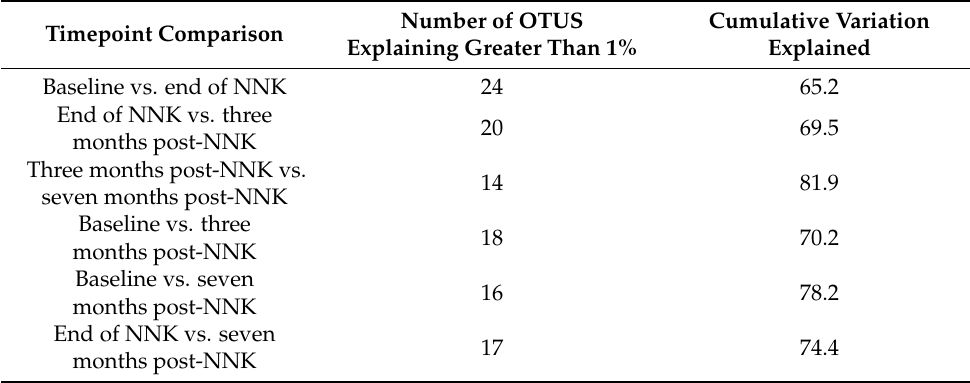
Table 4. Gprc5a − / − ; Lcn2 − / − lung microbiome SIMPER